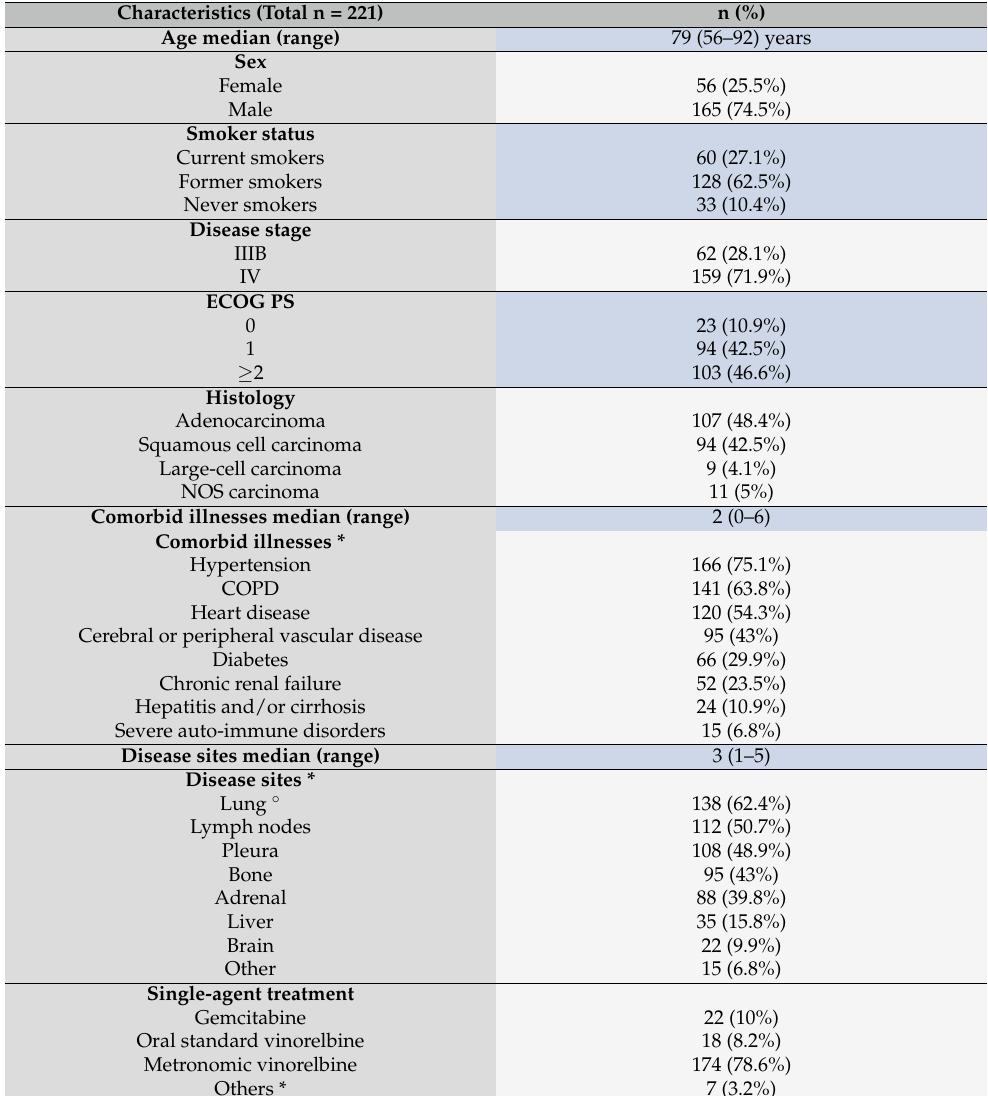
Table 1. Patients’ demographic, clinical-pathological characteristics and treatment